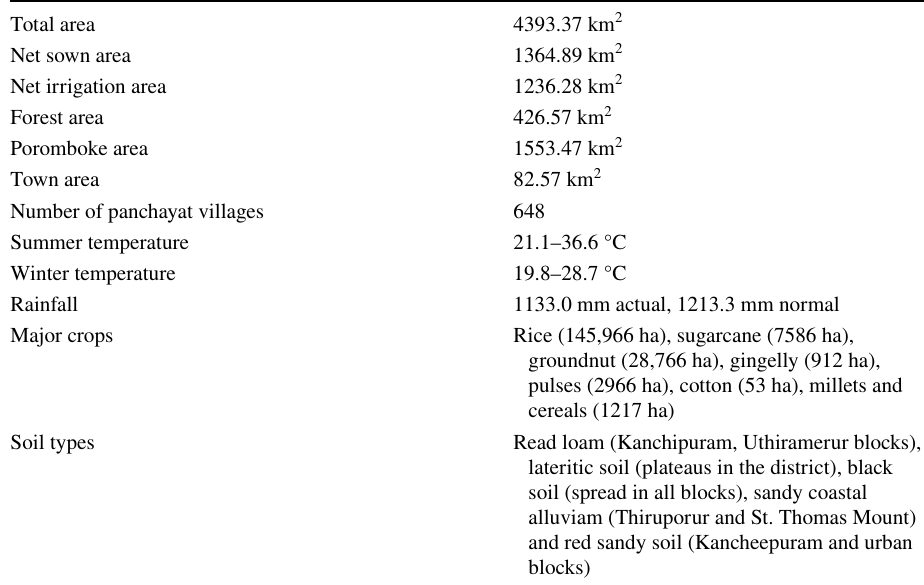
Table 1 General information about the study area (Source: www.kanch